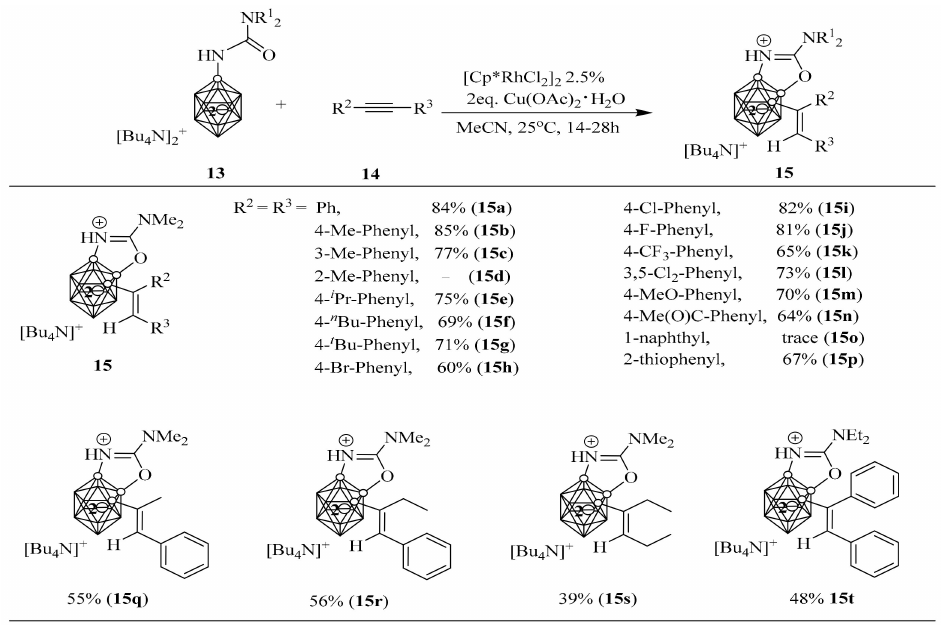
Figure 5. Synthesis of dodecaborate-fused oxazoles.